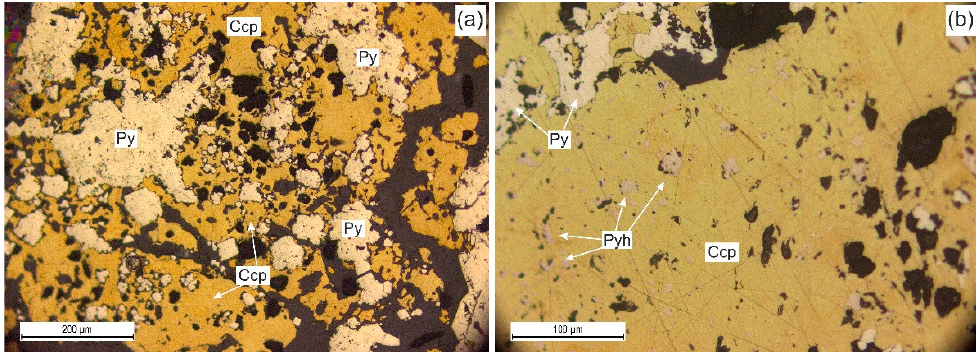
Figure 5. Chalcopyrite-pyrite layer in sample 242-1. ( a ) Chalcopyrite-pyrite intergrowths (sample 242-1/2). ( b ) Massive aggregate of coarse-grained chalcopyrite with primary unaltered pyrrhotite (sample 242-1/2).